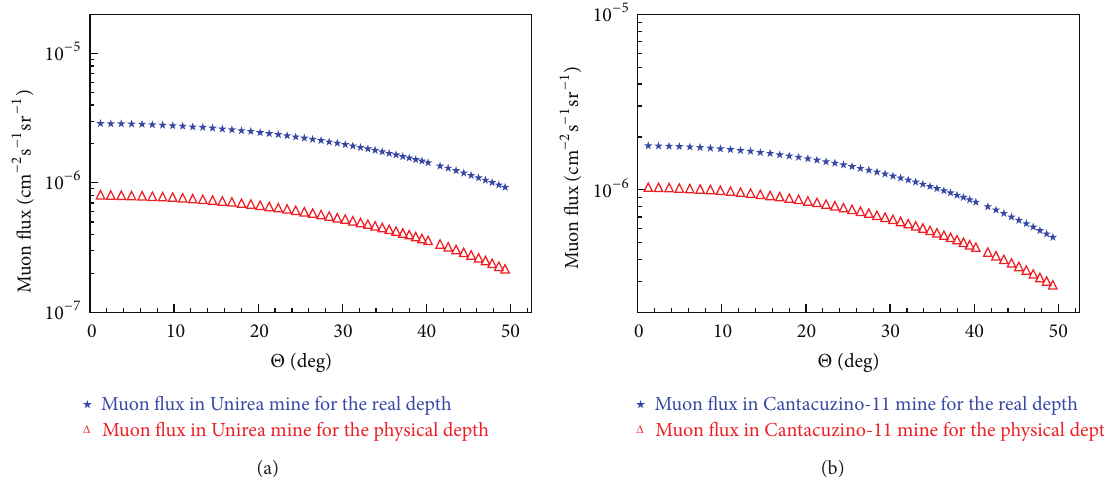
Figure 7: The directional variation of muon flux for the real and theoretical depths of Unirea mine (a) the directional variation of muon flux for the real and theoretical depths of Cantacuzino mine, level 11 (b).